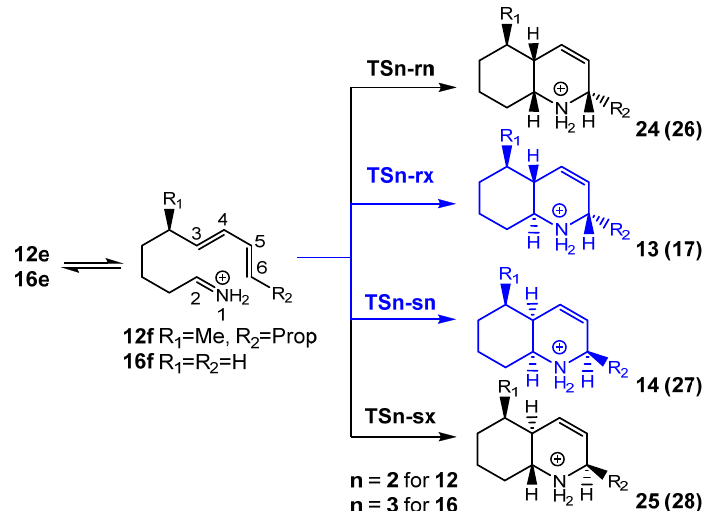
Scheme 7. Competitive reaction paths associated with the IIDA reactions of dieniminiums 12 and 16 .